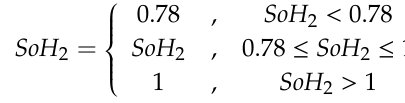
Figure 6. The relationship between dQ / dV and SoH with dV = 0.005 V. 4.2. Reasonable Selection of dV To guarantee the estimated efficiency and accuracy of this method, an appropriate dV needs to be selected. A reasonable choice of dV is 0.02 V. The larger the dV , the better the fitting effect and the more accurate the SoH estimation results. As can be seen from Figure 6, due to the relative amplification of noise, there are many obvious interference points when dV = 0.005 V. With the increase of dV, the noise is reduced relatively and dQ / dV also gets closer to the total capacity Q 2 of the current battery. In an extreme case, that is, the value of dV reaches the charging cut-off voltage, dQ / dV is numerically equal to Q 2 . According to Equation (2), the estimated SoH at this time is the actual SoH. Therefore, as mentioned above, the SoH estimation results become more accurate with increasing dV . However, with the increase of dV , the time required to calculate dQ also increases correspondingly, that is, the estimated efficiency is reduced. Additionally, nonlinear characteristics of the battery state of charge–open circuit voltage (SoC-OCV) curve determines the time taken to calculate dQ during the entire charging process is different. Overall, it is the maximum time to calculate dQ that limits the estimated efficiency. In order to improve the estimation efficiency on the basis of ensuring the accuracy of this method, the root mean square error (RMSE) of the fitting curves with SoC = 0.4 and the maximum time to calculate dQ is obtained by experiment, respectively, when dV = 0.005 V, 0.01 V, 0.02 V, 0.03 V and 0.05 V, as shown in Figure 7. It can be seen in Figure 7 that the RMSE comes close to 0 gradually with increasing dV . When dV increases to 0.2 V, the declining trend of RSME is obviously slowed down, and there is already no significant difference in the RMSE at dV = 0.03 V and 0.05 V. As for the maximum time, it can be seen from Figure 7 that the maximum time growth trend is linear with increasing dV . Generally, as can be seen in Figure 6, when dV is 0.01 V or less, the noise is relatively amplified and the linearity of dQ and SoH is not satisfactory enough. However, when dV is 0.03 V or more, the maximum required time to calculate dQ is too long. Consequently, dV = 0.02 V is a reasonable option.